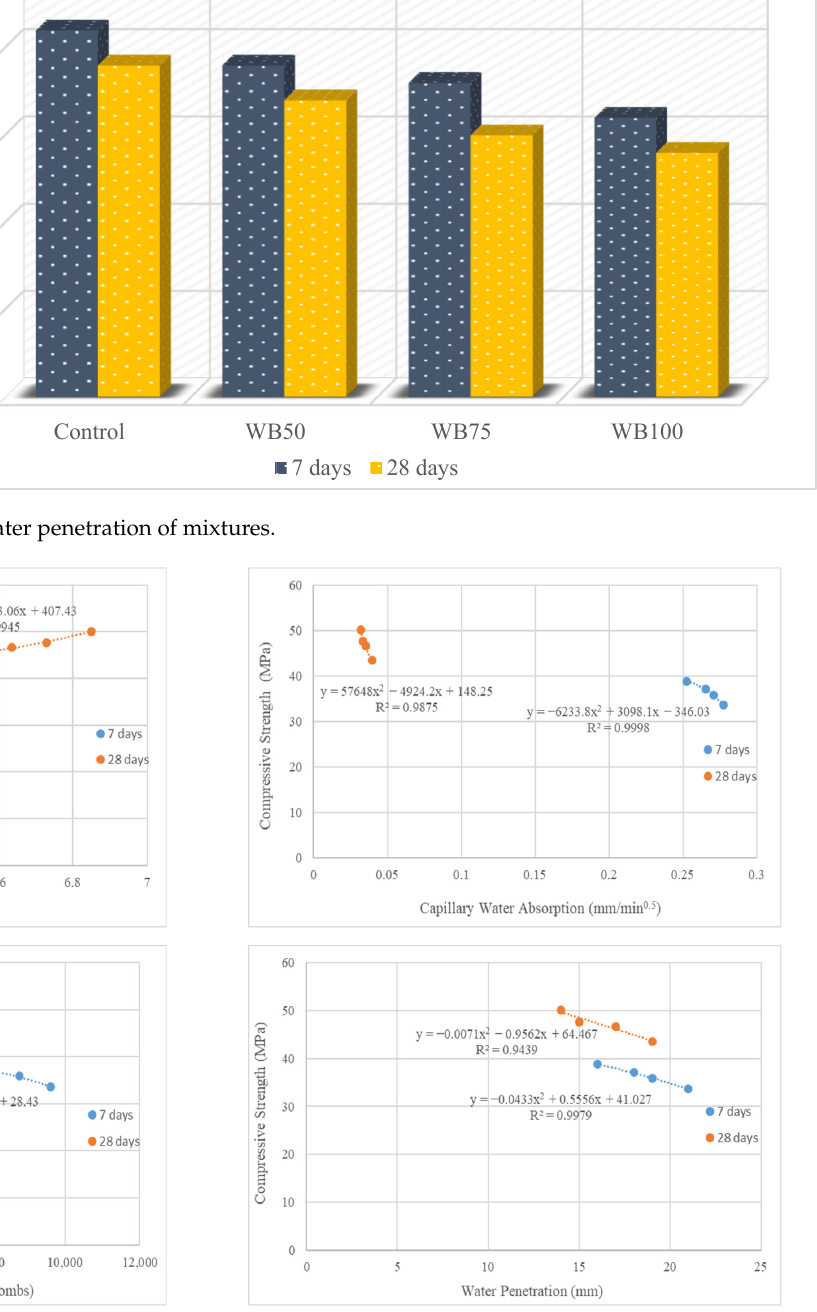
Figure 8. Water penetration of mixtures.